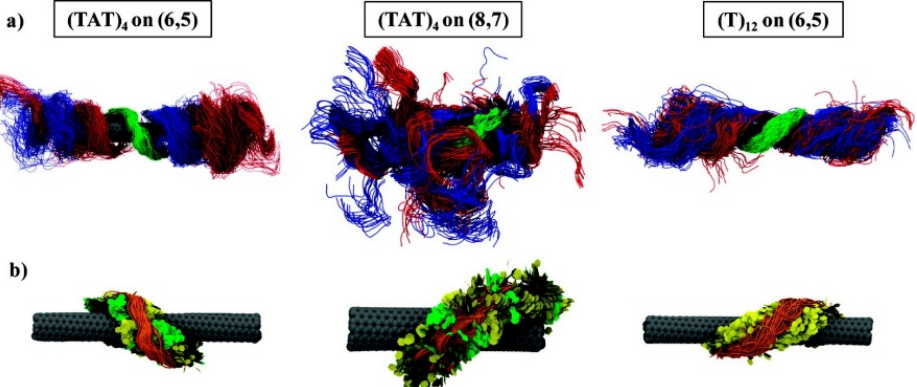
Figure 6. Recent theoretical models of several combinations of ssDNA and SWNTs, proposed by Roxbury et al. (Reprinted from reference [169] with